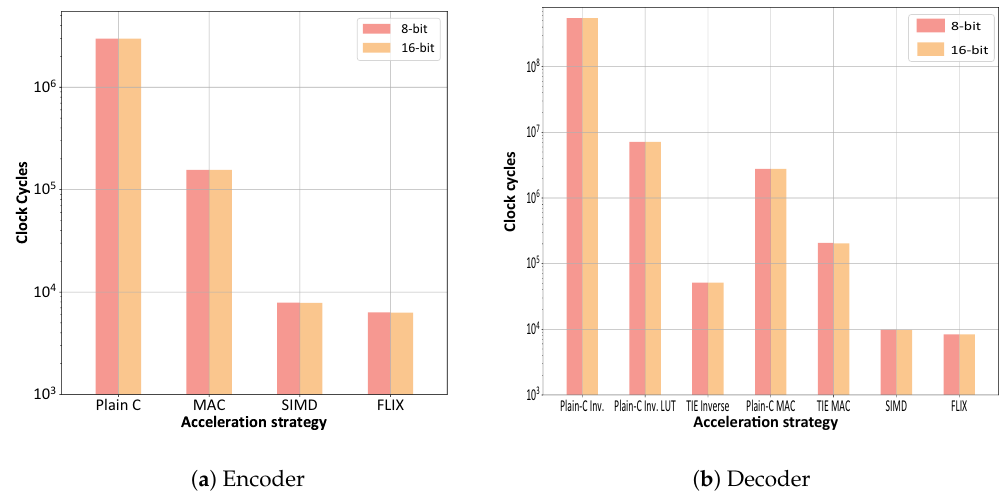
Figure 5. Comparison of number of clock cycles for random linear network coding (RLNC) with a generation size of g = 16 and packet size of m = 1536 bytes. The plain C results correspond to the implementation without any application specific Tensilica Instruction-set Extension (TIE). The MAC, SIMD, and FLIX results correspond to the different examined TIEs with the LX5 core instruction-set. For the decoder, we separately report in part ( b ) the numbers of clock cycles for the matrix inversion, specifically with elementary multiplication operations (Plain C Inv.) with a look-up table (Plain C Inv. LUT) and with a TIE (TIE Inverse), and for the matrix multiplication (MAC without and with TIE), as well as the numbers of clock cycles for the complete decoding with SIMD and FLIX